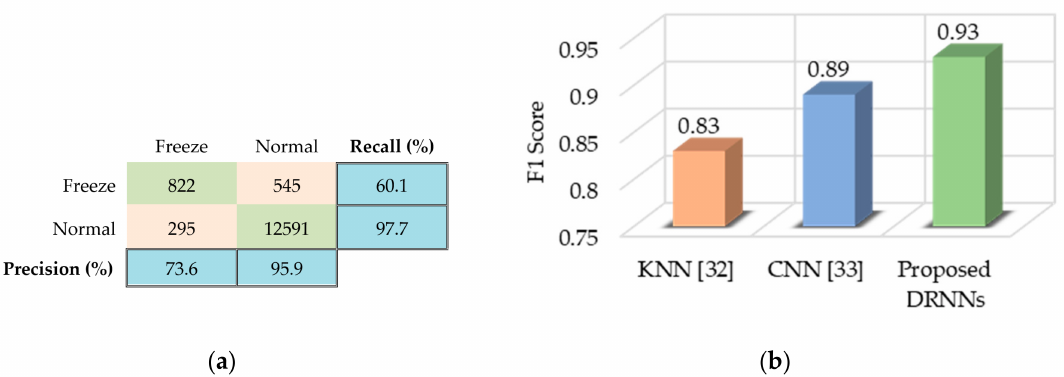
Figure 11. Performance results of the proposed cascaded DRNN model for the Daphnet FOG dataset: ( a ) Confusion matrix for the test set, along with per-class precision and recall; ( b ) F1 score of the proposed method in comparison with other methods.